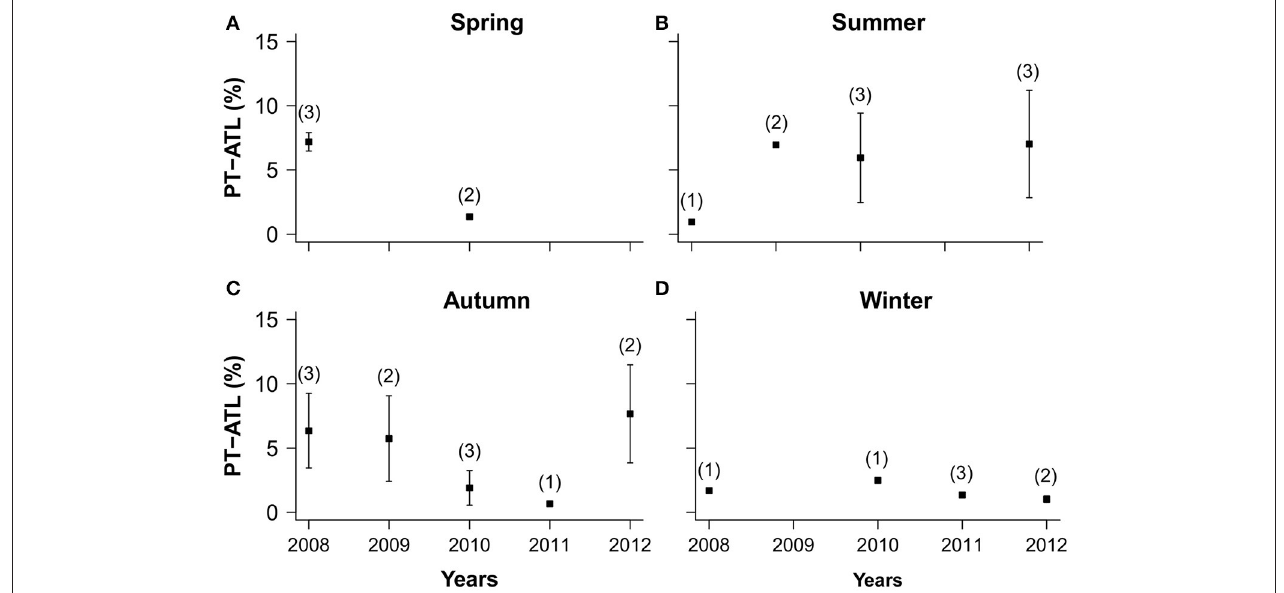
FIGURE 7 | Inter-annual variability in averaged seasonal PT-ATL values for Condor seamount and standard deviations (error bars). Numbers in brackets are number of months with data representing each of the following seasons: (A) Spring: March–June; (B) Summer: June–September; (C) Autumn: October–November; (D) Winter: